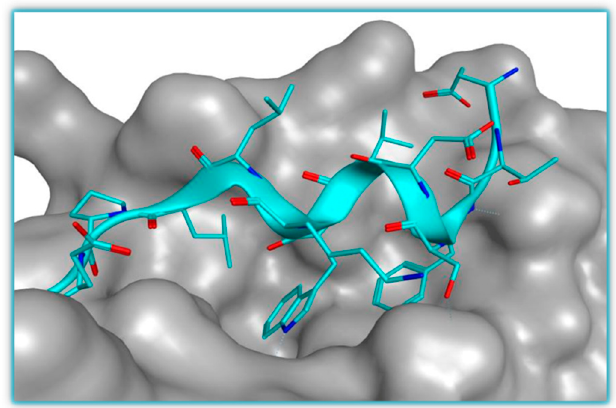
Figure 1. The p53-MDM2 interaction representation (PDB 1YCR). Phe19, Trp23 and Leu26 from a small amphipathic p53 derived α -helix (blue) are projected into the MDM2 pocket (grey surface).